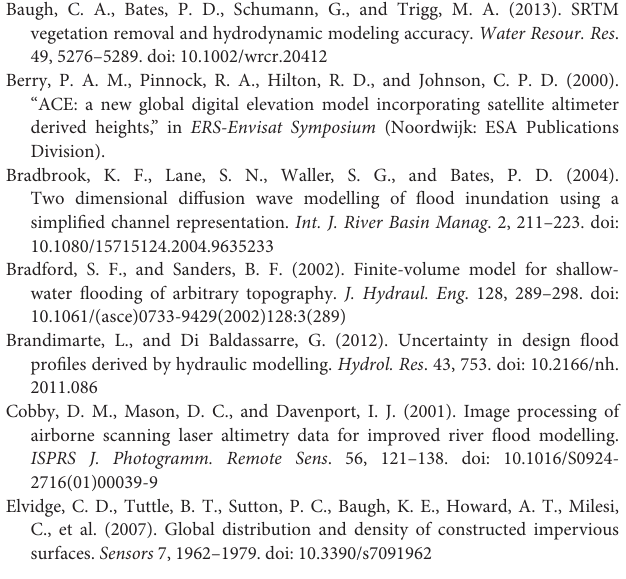
DEM becomes able to resolve individual streets due to correct representation of floodplain connectivity (Fewtrell et al.,